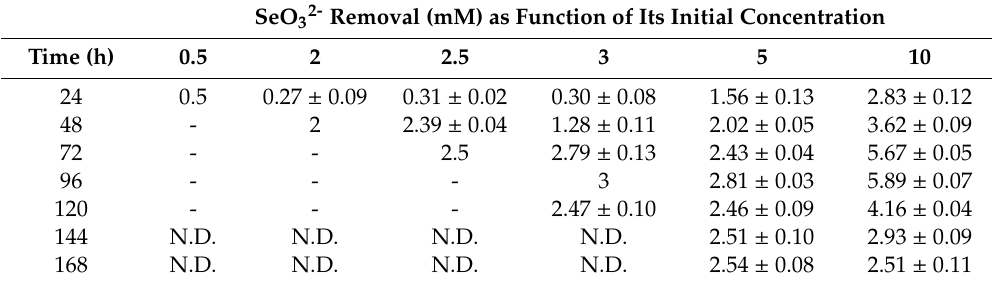
Table 1. SeO 32 − bioprocessing efficacy of MPV1 cultures grown in LB medium over time. SeO 32- Removal (mM) as Function of Its Initial Concentration